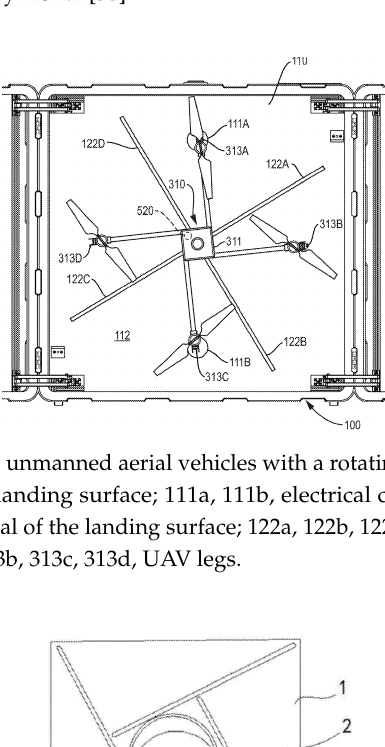
Figure 16. Example of a commercially available landing platform with rotating pushers ( a , b ) for a UAV with eccentric beams ( c ) by Easy Aerial [58].